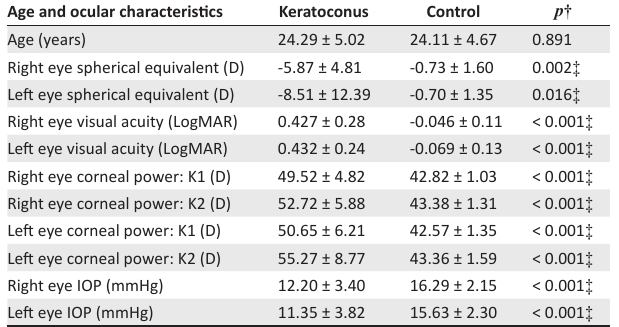
TABLE 2: Means and standard deviations for retinal nerve fibre layer thickness ( µ m) in the keratoconus and control groups stratified for the right and left eyes. RNFL